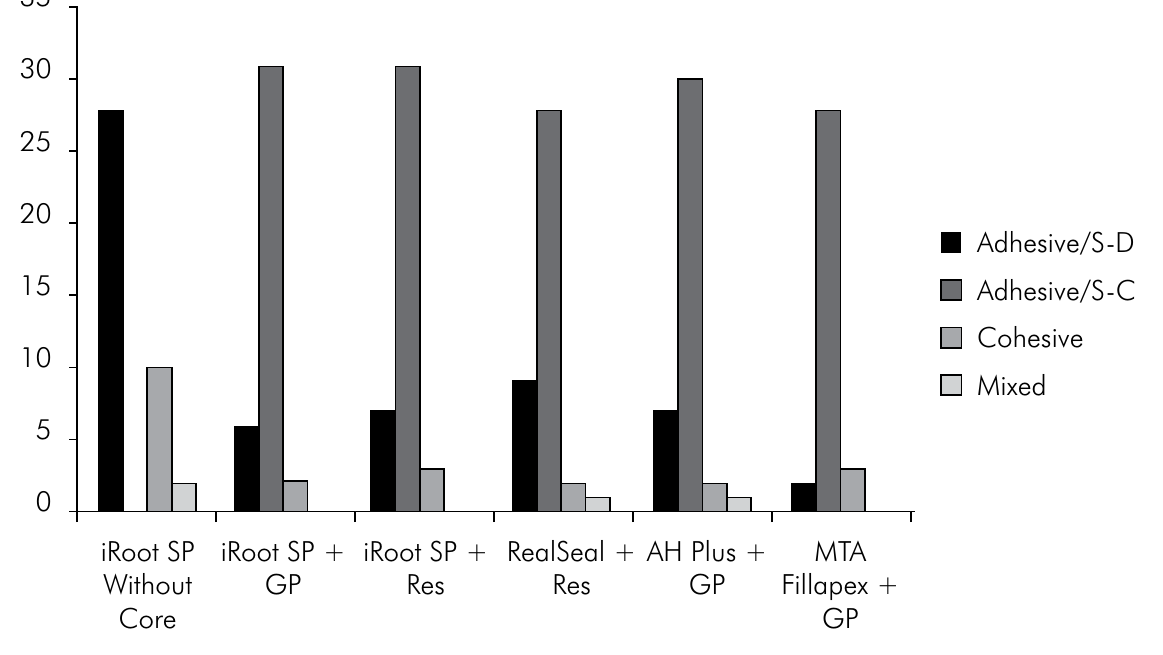
Figure 1. Distribution of failure modes (GP= Gutta-percha, RES=Resilon, S-D= Between sealer and dentin, S-C=Between sealer and core